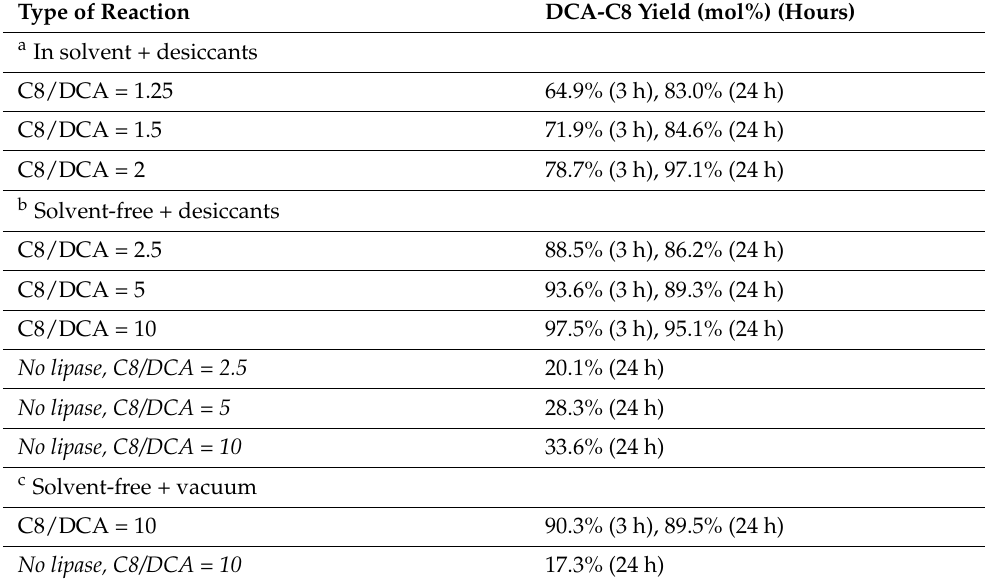
Table 1. DCA-C8 yields in different reactions with an excess of octanoic acid, both in solvent and solvent-free conditions. The C8/DCA values displayed correspond to the molar ratio between the two substrates.